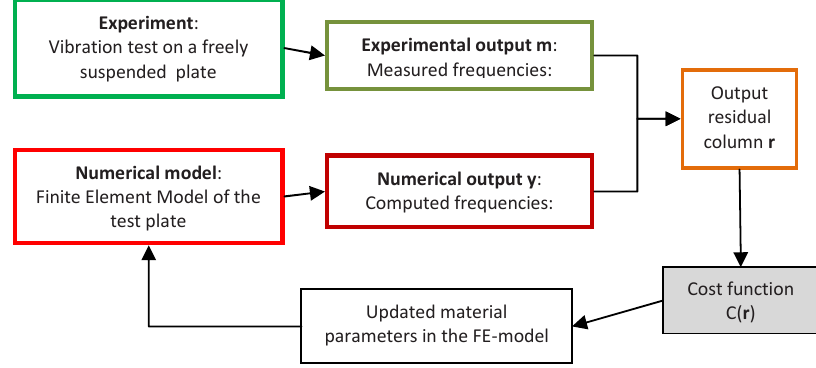
Fig. 1. Principle of an inverse method for material identification